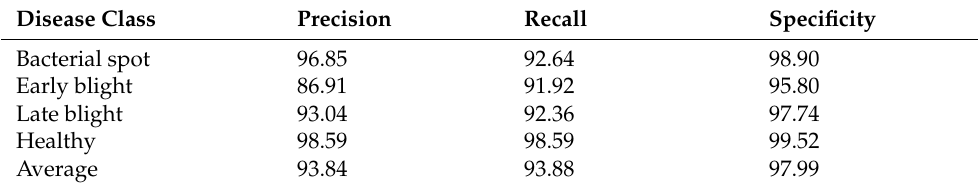
Table 7. Performance evaluation of individual classes of Tomato diseases using VGG and Xgboost. Disease